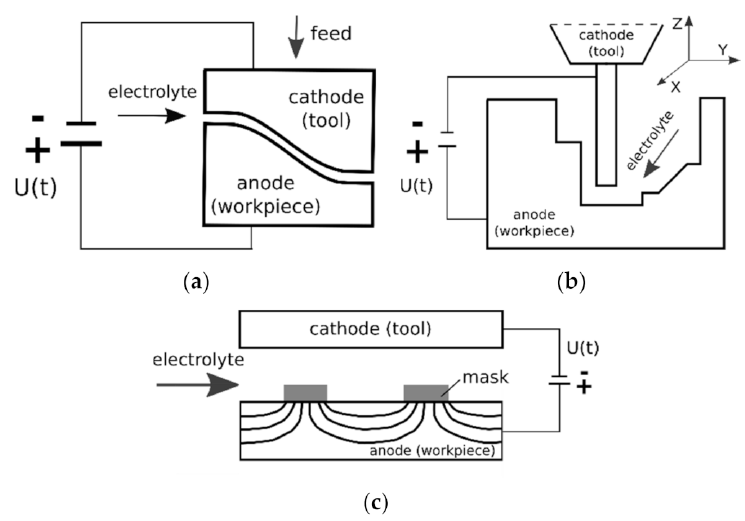
Figure 5. Variants of electrochemical micromachining: ( a ) sinking, ( b ) machining with universal electrode tool, and ( c ) through mask electrochemical micromachining [28].